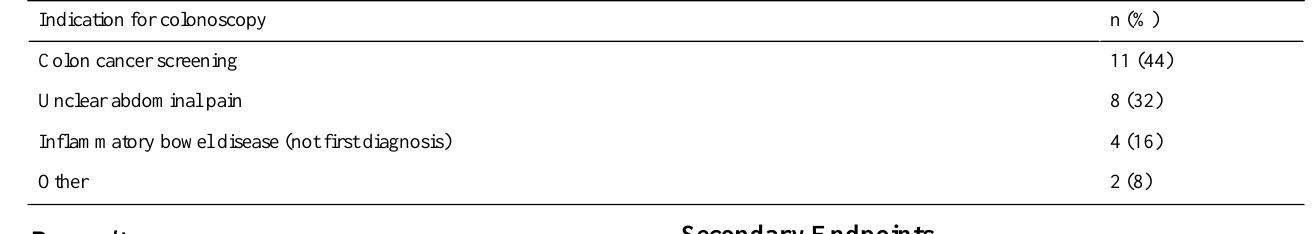
Table 2. Indications for colonoscopy